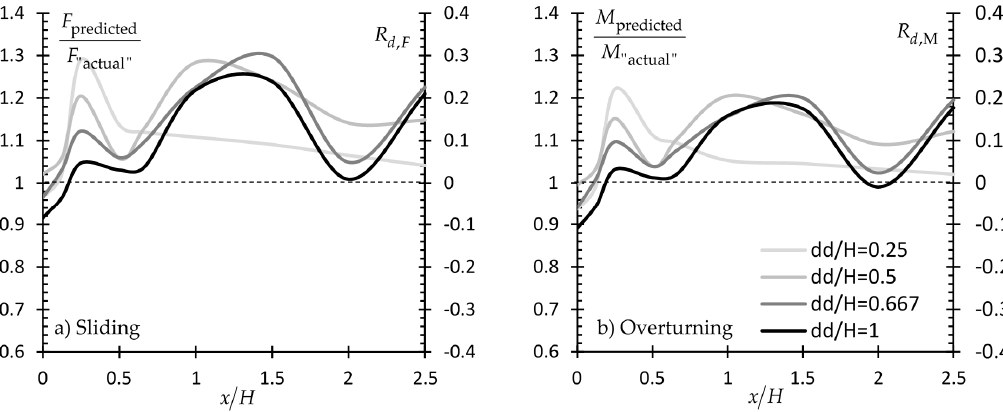
Figure 21. Example #2: F predicted / F ”actual” ( a ) and M predicted / M ”actual” ( b ) vs. x / H curves for various d d / H values and for both the sliding and overturning failure cases (see also Table 1 and Figure 18).